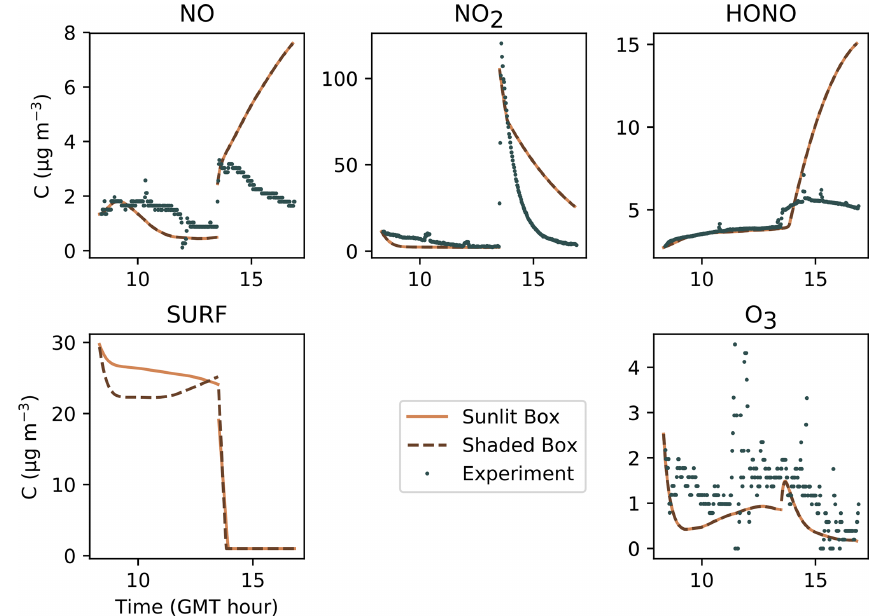
Figure 23. Implementation of a surface saturation effect using the compound SURF. The dots denote the experimental records, the solid lines denote the concentrations simulated in the sunlit box, and the dashed lines denote the concentrations in the shaded